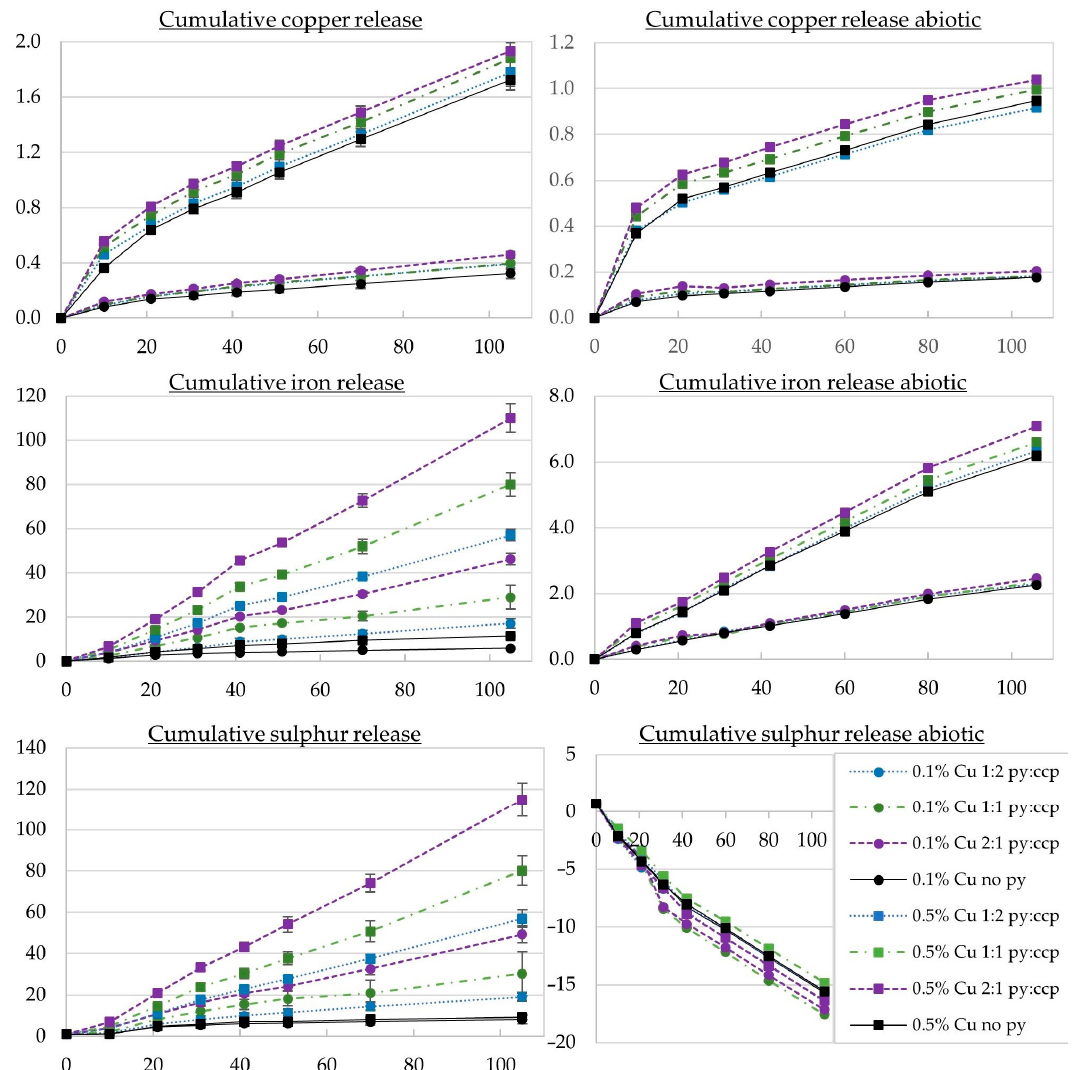
Figure 1. Cumulative copper, iron and sulphur solubilisation over time for both inoculated and abiotic systems. X-axes is time (days), Y-axes is cumulative mass (mg). Values shown are averages of three columns, with standard deviation as error bars.